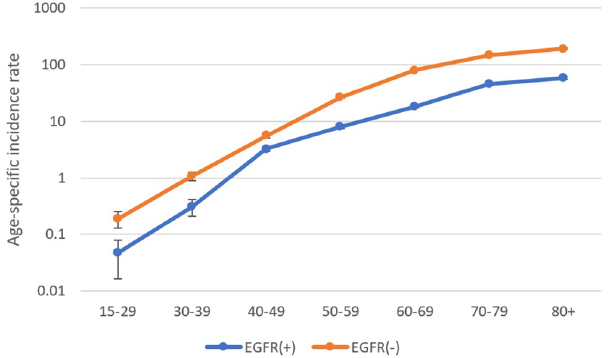
Fig 1. Age-specific incidence rates (cases per 100,000 person-years) of non-squamous non-small cell lung cancer by EGFR mutation status, estimated based on the EGFR mutation tested proportions, shown in age groups. The vertical error bars represent 95% confidence intervals of incidence